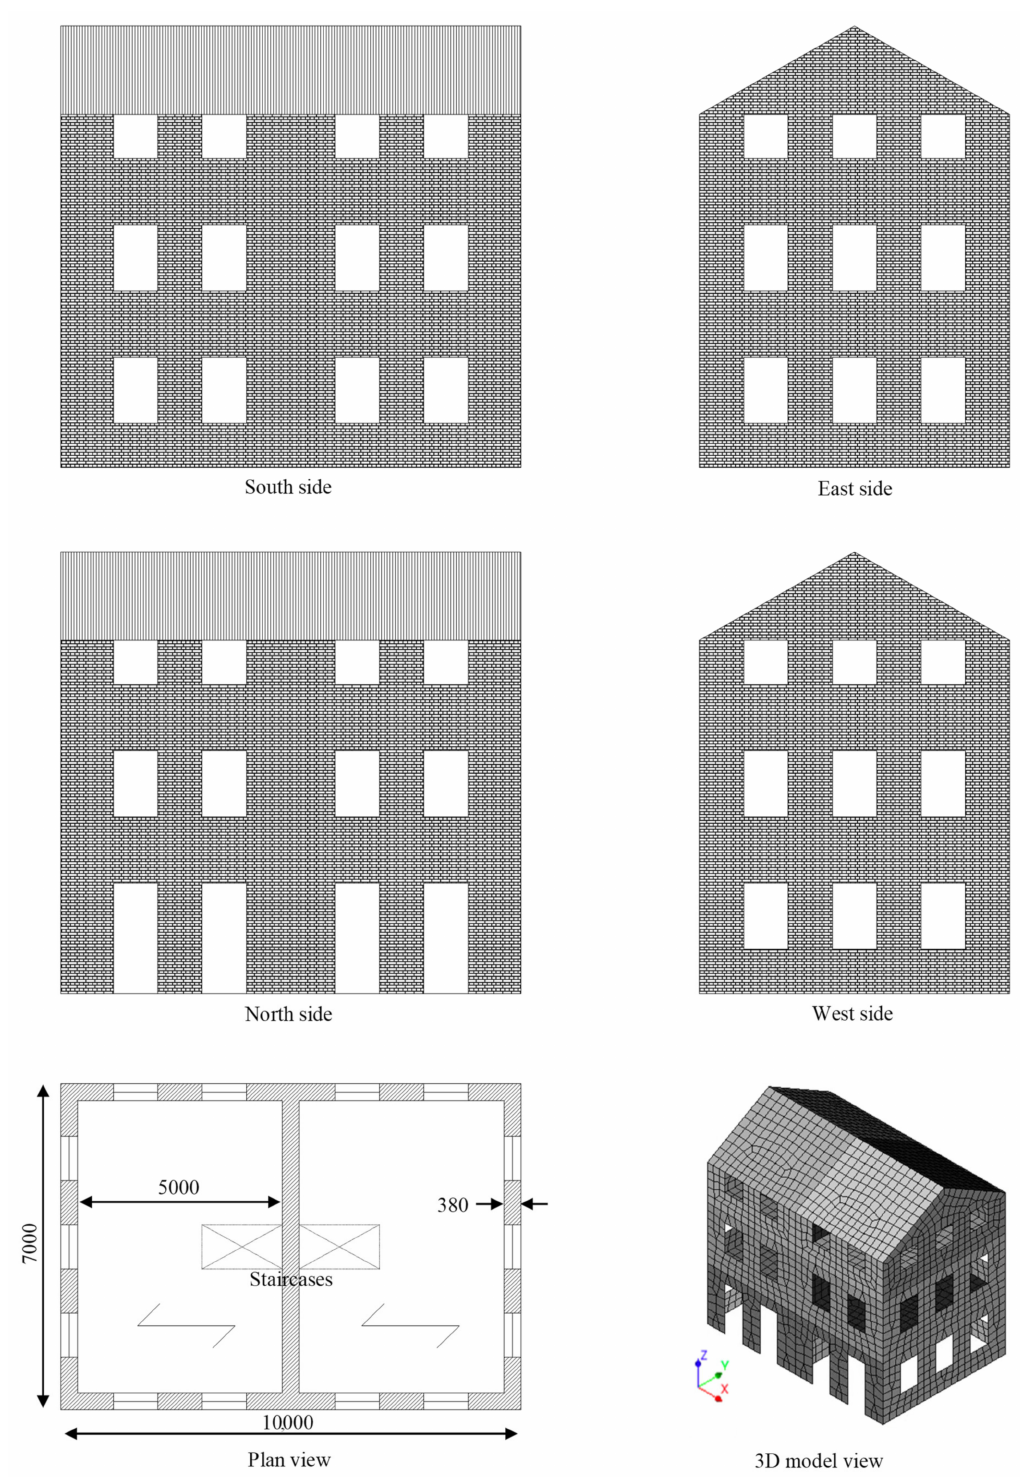
Figure 8. Main properties and geometry of the third case–study building B3 (dimensions in mm). In all configurations, continuous, hinged connections at the floor supports were assumed, as, in the as-built case, adequate floor-to-wall joints were also